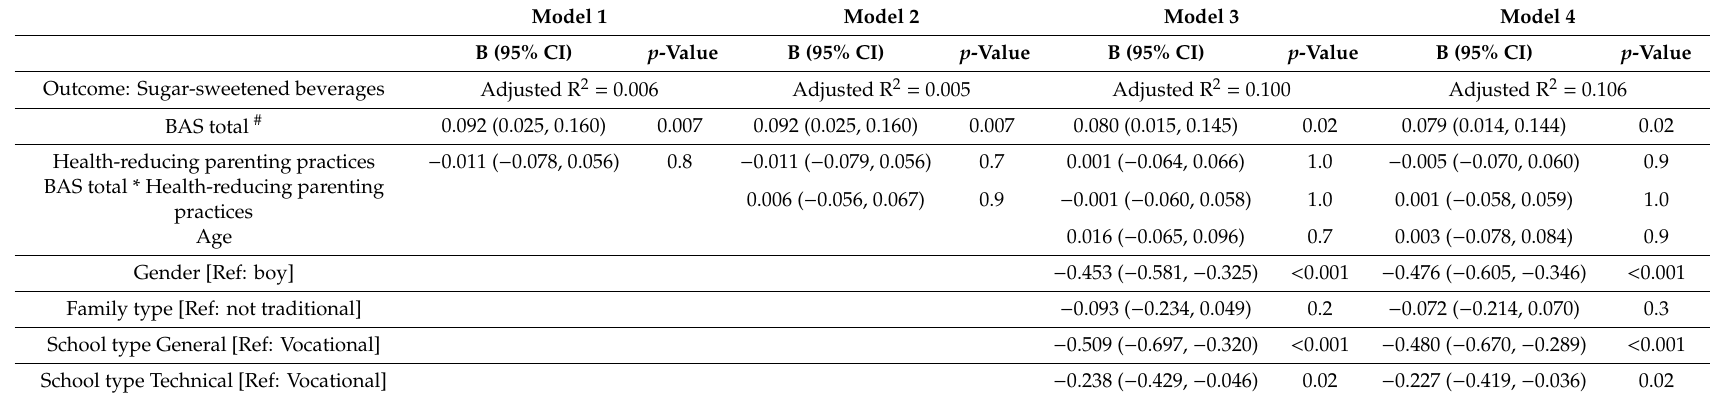
Table 3. Associations between reward sensitivity and adolescents’ intake of sugar-sweetened beverages, healthy and unhealthy snacks, and the moderating role of (adolescent-reported) health-reducing parenting practices ( n =